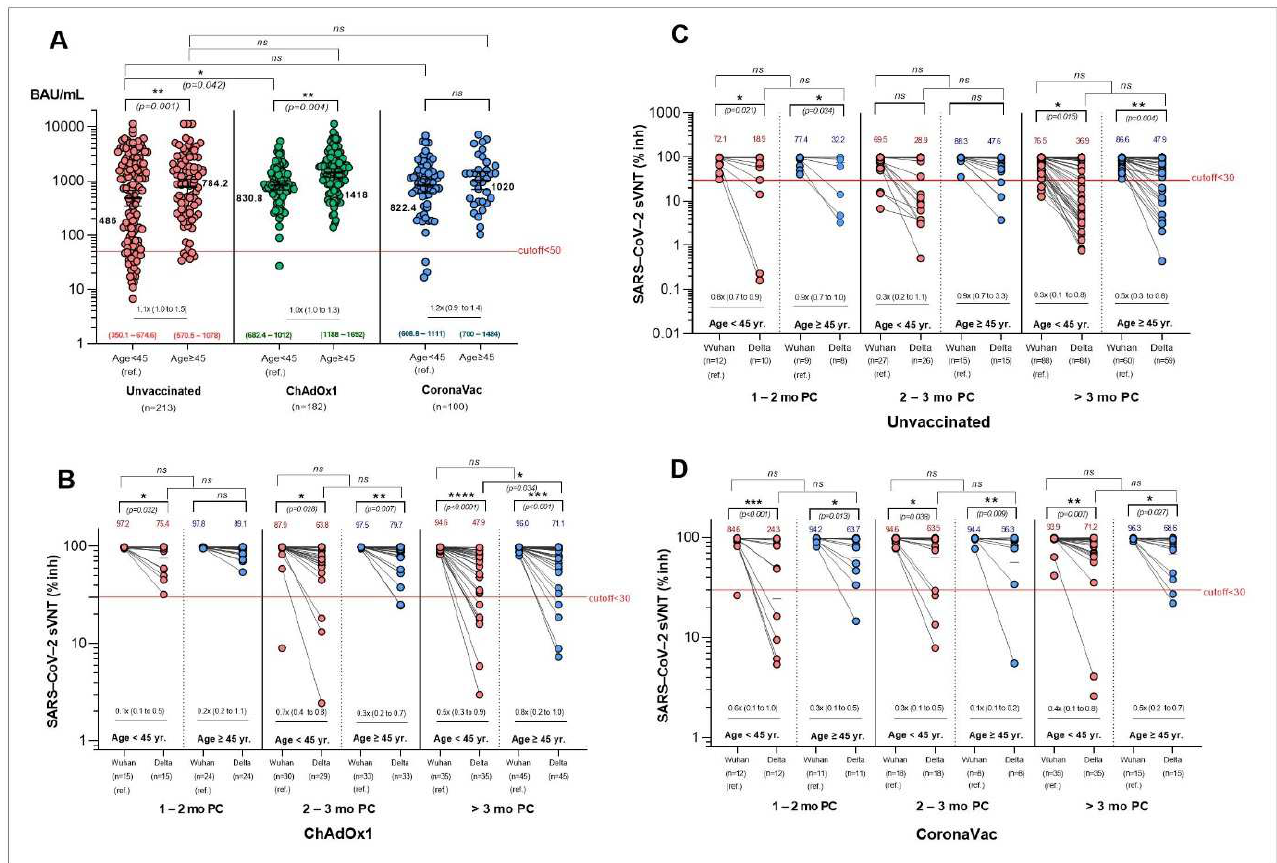
Figure 8. Immune responses after breakthrough COVID-19 infection with prior CoronaVac or ChAdOx1 vaccination during the Delta pandemic. Antibodies (Anti-RBD IgG) ( A ) by age/vaccination, and sVNT ( B – D ) by age groups/vaccination/infection status. * p < 0.05; ** p < 0.01; *** p < 0.001; **** p <